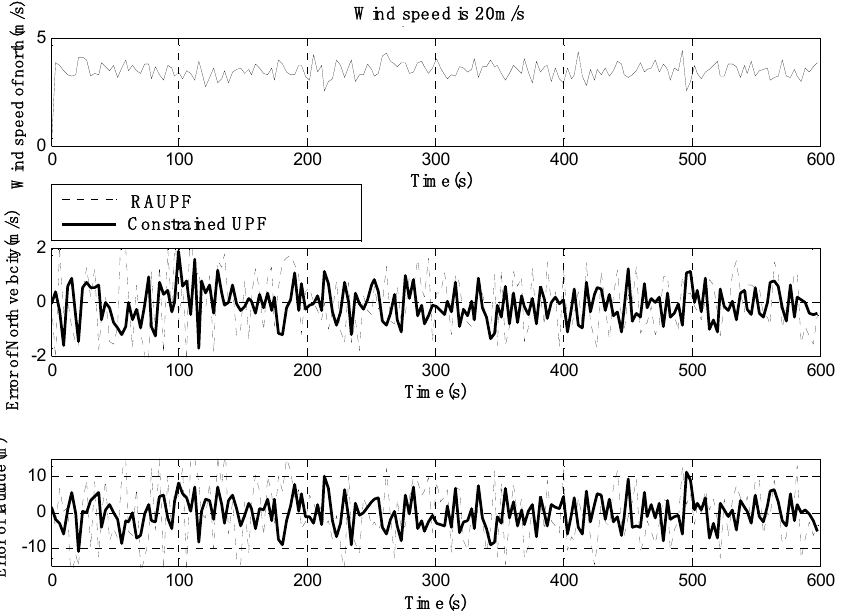
Figure 7. East velocity and longitude errors under the wind speed of 20 m/s.